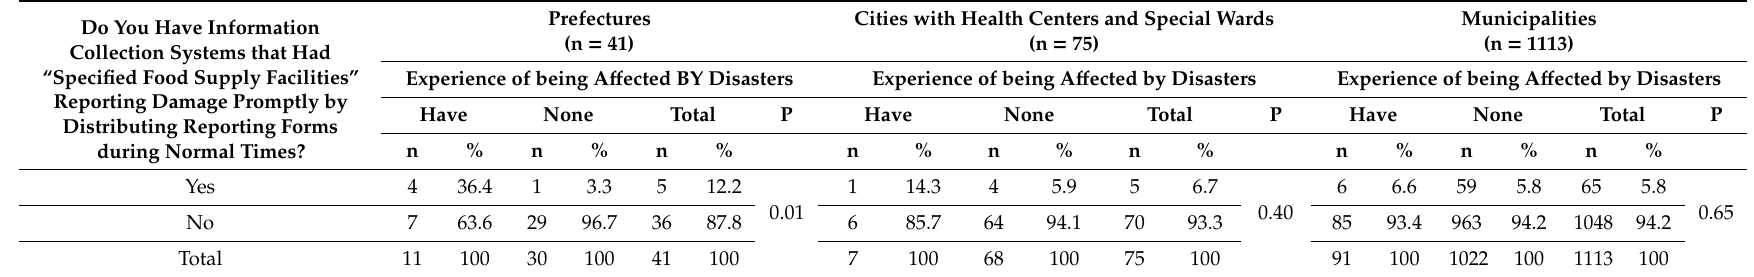
Table 4. Authorities with information collection systems that had “specified food supply facilities” reporting damage promptly by distributing reporting forms during normal times. Data from 2013